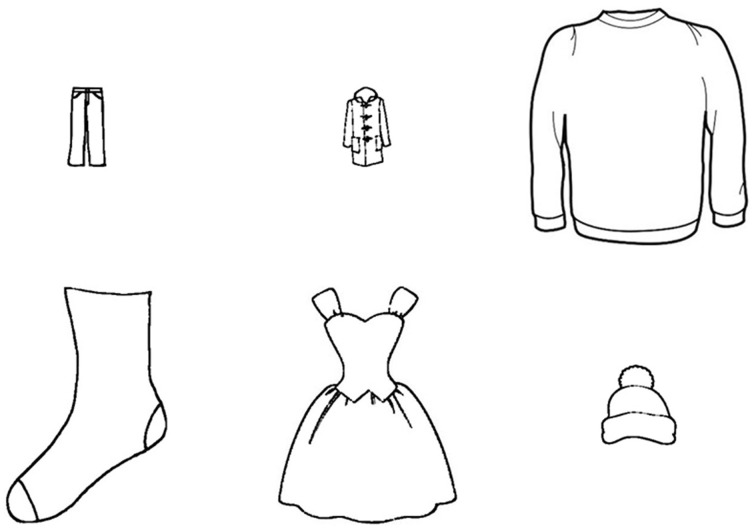
An array in the Size condition in Experiment 3.